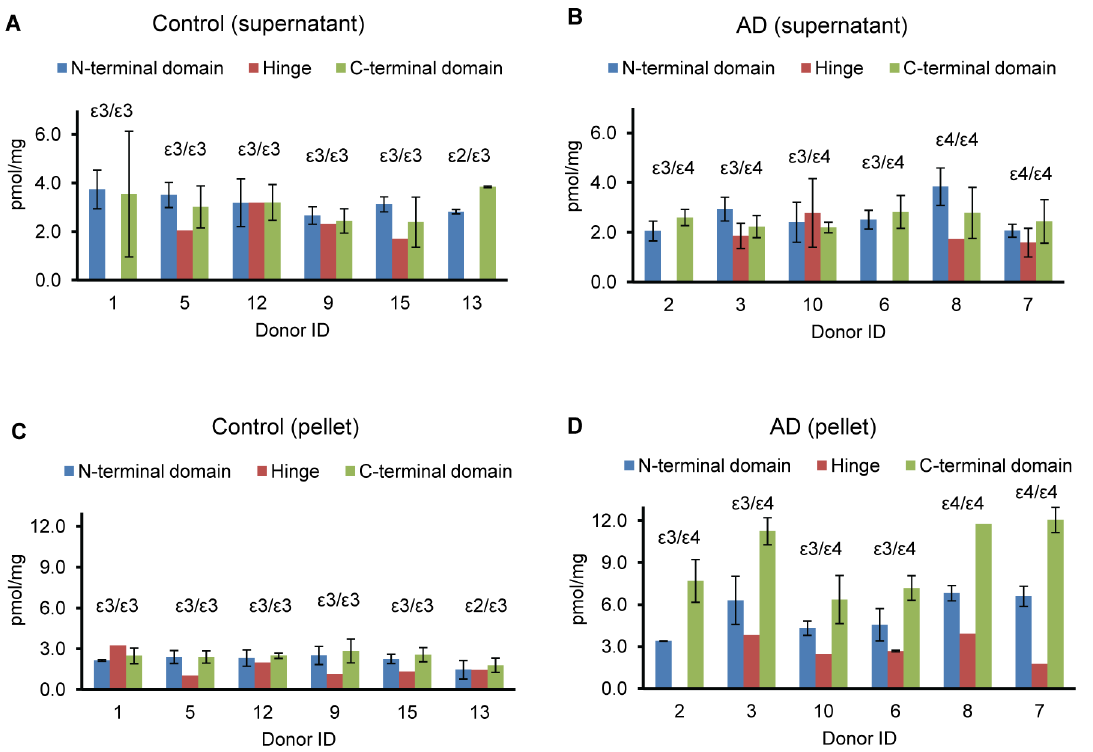
Figure 3. Quantification of total apoE in supernatant and pellet fractions of whole frontal cortex homogenate. Measurements were performed on the control (A and C) and severe AD (B and D) frontal cortex. The supernatant (A and B) and pellet (C and D) fractions were generated by centrifugation of whole frontal cortex homogenate at 153,000 6 g for 30 min. The concentration of total apoE in pmol/mg total protein was calculated based on peptides in the N-terminal, hinge, and C-terminal domains and is color coordinated. The concentration was calculated for three experimental replicates by monitoring three transitions per individual peptide. For N-terminal and C-terminal domain the data for three signature peptides were combined. All final data are presented as the mean 6 SD.